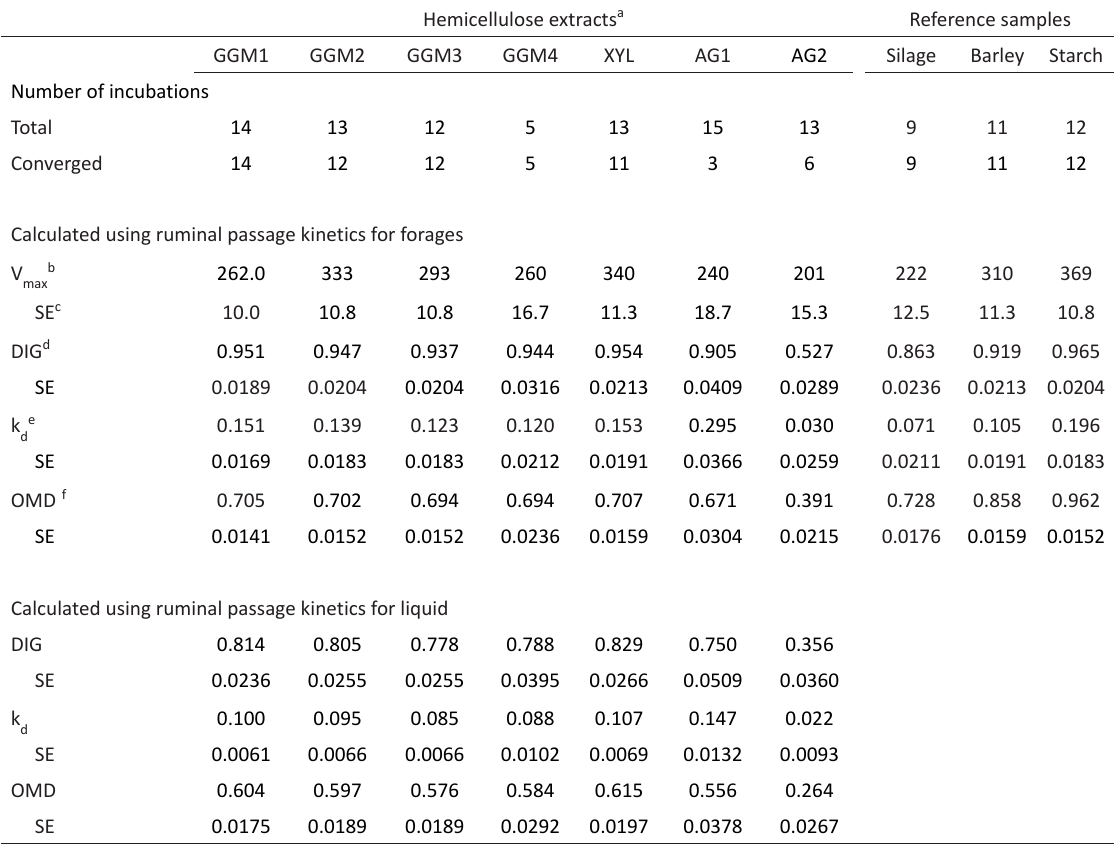
Table 1. In vitro gas production results of wood based hemicellulose extracts and reference samples measured using ruminal digesta passage kinetic parameters for forage and liquid Hemicellulose extracts